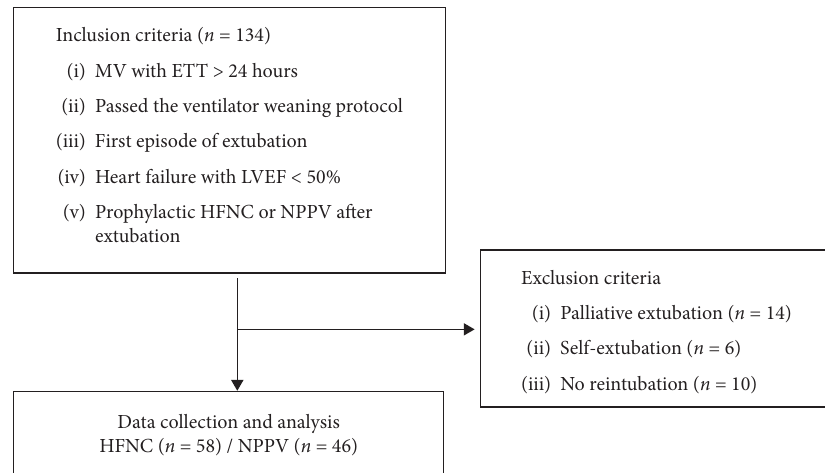
Figure 1: Retrospective flow chart of patients included in analyses between January 2015 and January 2018. ETT, endotracheal tube; HFNC, high-flow nasal cannula; MV, mechanical ventilation; NPPV, noninvasive positive pressure